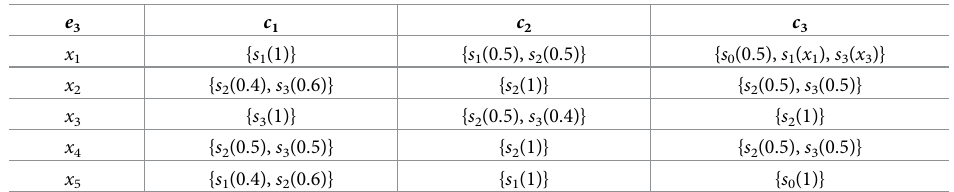
Table 3. The decision matrix of e 3 .